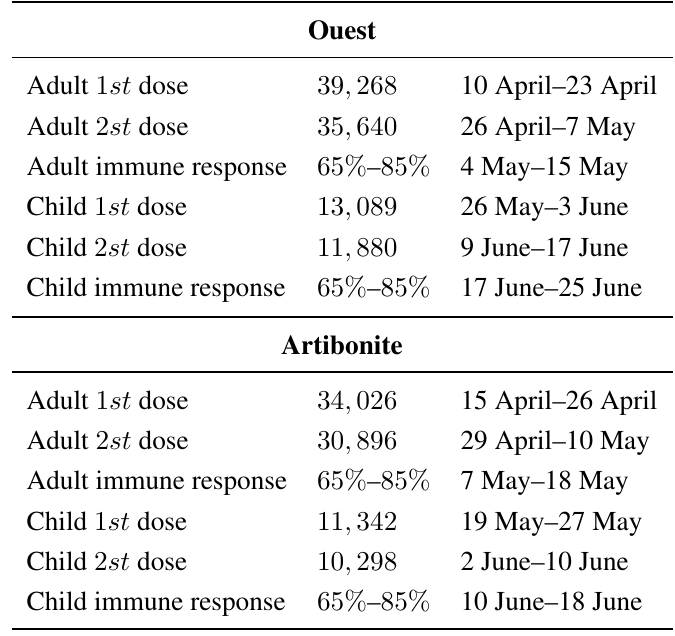
Table 5. Simulated vaccination schedule for Artibonite and